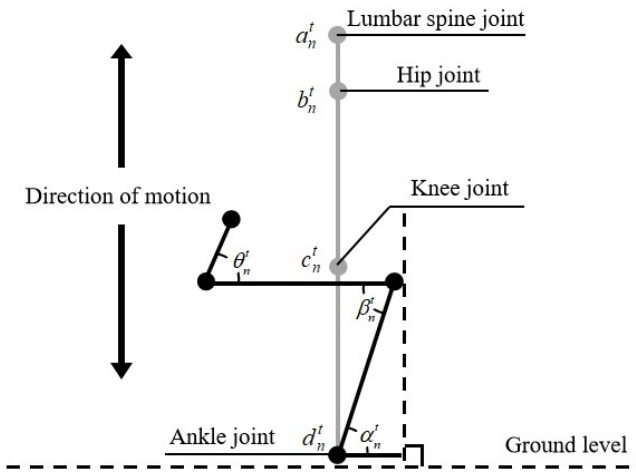
Figure 5. The sagittal lower limb squatting bat model.